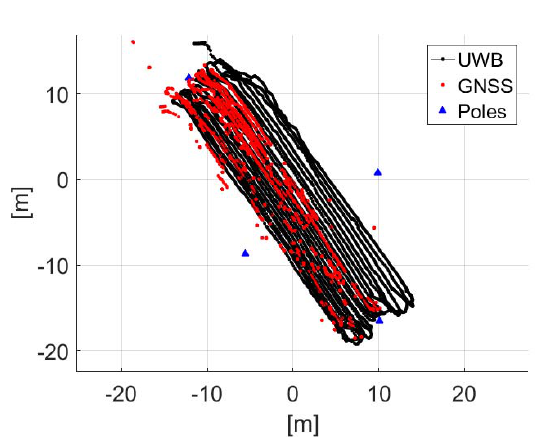
Figure 9. UWB (black) and GNSS (red) trajectory solutions